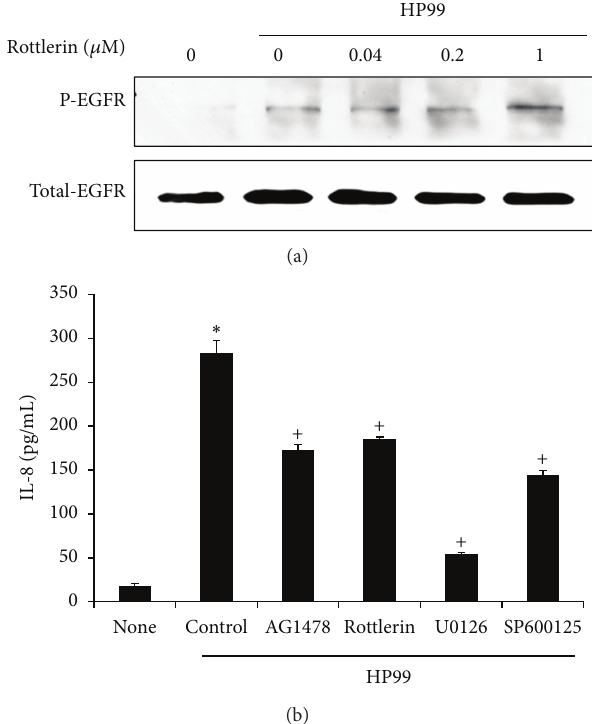
Figure 7: Effect of a PKC 𝛿 inhibitor on EGFR activation and effects of inhibitors of EGFR, PKC 𝛿 , ERK, and JNK on H. pylori - stimulated IL-8 production. (a) AGS cells were preincubated with various doses of rottlerin (0.04, 0.2, and 1 𝜇 M) for 1h and were then cultured with H. pylori for 15min. Phosphospecific and total forms of PKC 𝛿 were determined by western blotting. (b) AGS cells were preincubated with AG1478 (1 𝜇 M), rottlerin (1 𝜇 M), U0126 (20 𝜇 M), and SP600125 (20 𝜇 M) for 1h and were then infected with H. pylori for 4 h. IL-8 levels in the medium were measured by enzyme-linked immunosorbent assay. Each bar represents mean ± S.E. of four separate experiments. ∗ 𝑃 < 0.01 versus None; + 𝑃 < 0.01 versus control.